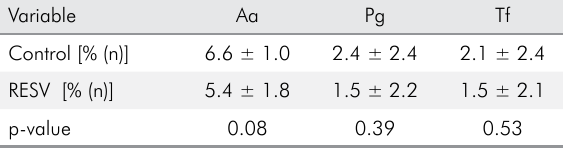
Table 1. Mean ± standard deviation of the concentration (log [ ]) of the periodontal pathogens Aggregatibacter actinomycetemcomitans Aa, Porphyromonas gingivalis Pg and Tannerella forsythia Tf in ligatures from the control and RESV groups. Variable